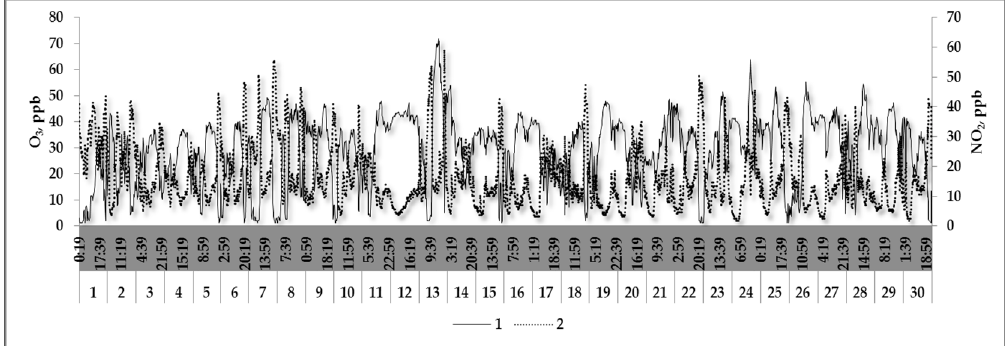
Figure 3. Variability of the hourly concentrations of ozone (1) and NO 2 (2) in Irkutsk during April 2015.